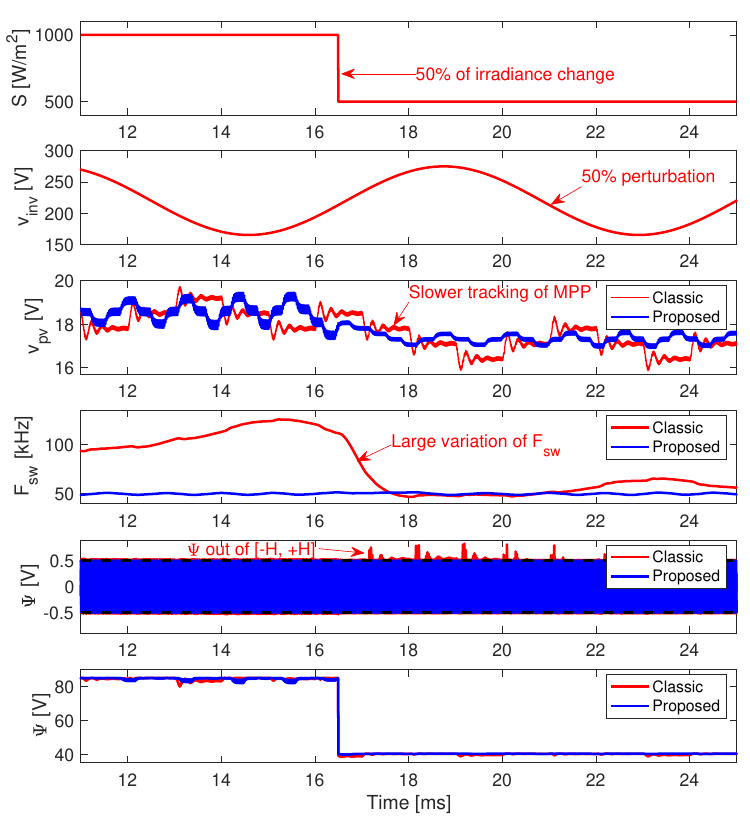
Figure 16. Performance comparison of both the classical and proposed control solutions.